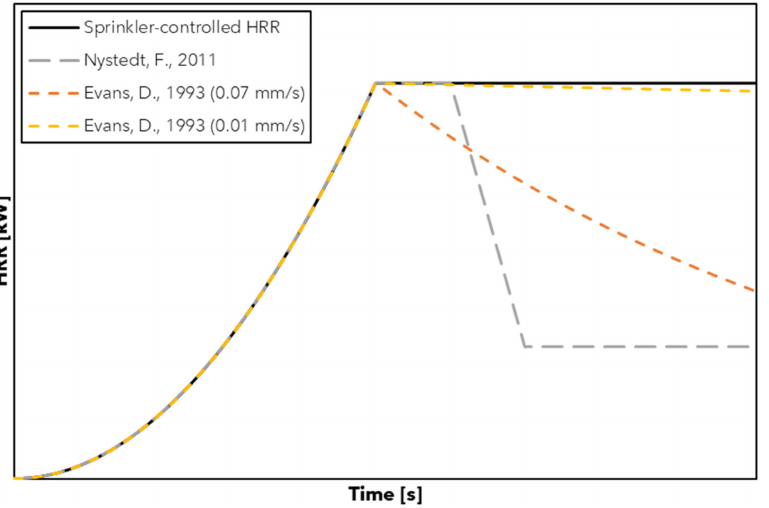
Figure 1. Example suppression models commonly adopted in fire modelling, including a sprinkler- controlled HRR [5], the Nystedt model [7], and the Evans model [8]. For a design fire impacted by sprinkler suppression, Nystedt [7] suggests that the following correlation can be used: (a) at the time of sprinkler activation, the HRR remains constant for 60 s; (b) following this, the fire decays to 1/3 of its maximum HRR (at the time of sprinkler activation) linearly over a 60 s period; and (c) for the remaining time, the HRR remains constant at 1/3 of the maximum HRR. An example of this is presented in Figure 1. Nystedt suggests that this can be applied for deterministic fire modelling where the maximum HRR is less than 5000 kW, but that “ the heat release rate should remain constant at the time of sprinkler activation ” for fires which are larger than 5000